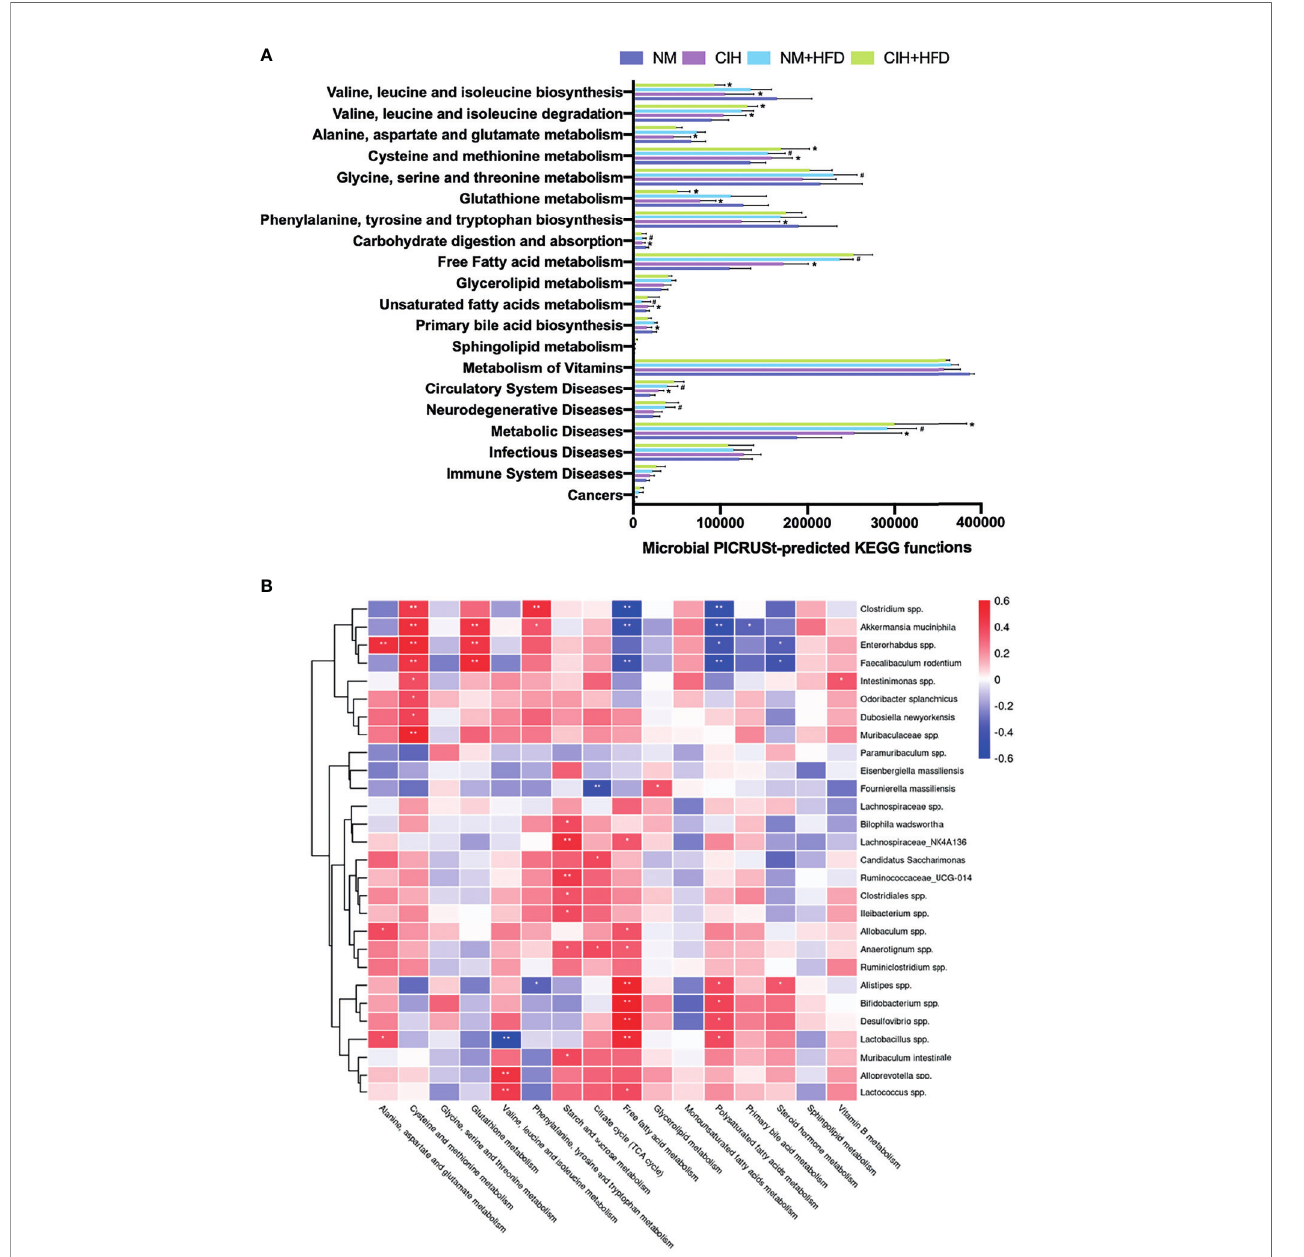
FIGURE 8 | CIH-related fecal microbiota functional changes and correlations between the host metabolome and fecal microbiome. (A) Microbial PICRUSt ‐ predicted KEGG functions relevant to metabolism and diseases. Data are expressed as mean ± SEM. Group differences were assessed by using the Mann ‐ Whitney U test. *P < 0.05 when comparing NM vs CIH, or NM+HFD vs CIH+HFD. # P < 0.05 when comparing NM vs NM+HFD. (B) Spearman correlations of the relative abundance of fecal microbial genus or species and the abundance of metabolite pathways in host serum (n = 36). The r values are represented by gradient colors, with red cells indicating positive correlations and blue cells indicating negative correlations. *P < 0.05, and **P <